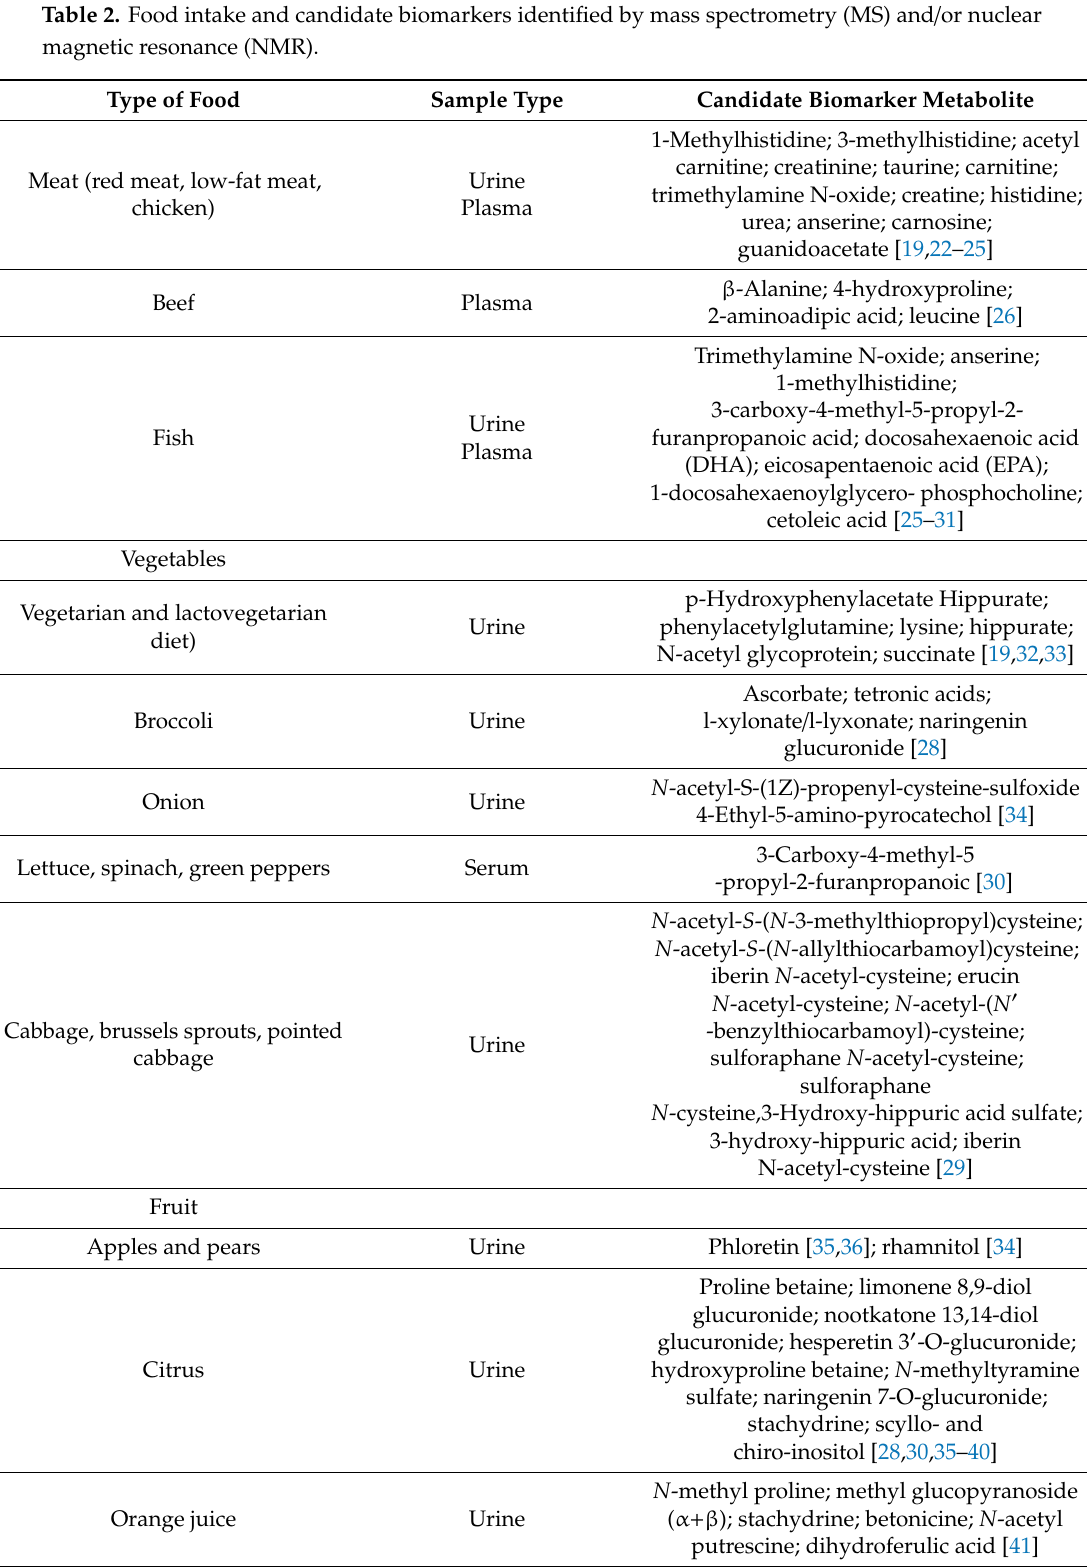
Table 2. Food intake and candidate biomarkers identified by mass spectrometry (MS) and / or nuclear magnetic resonance